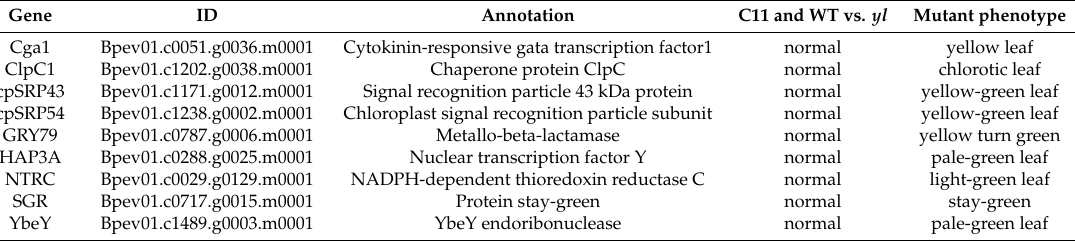
Table 4. The expression of well-known genes related to leaf color in the transcriptional level of a yl